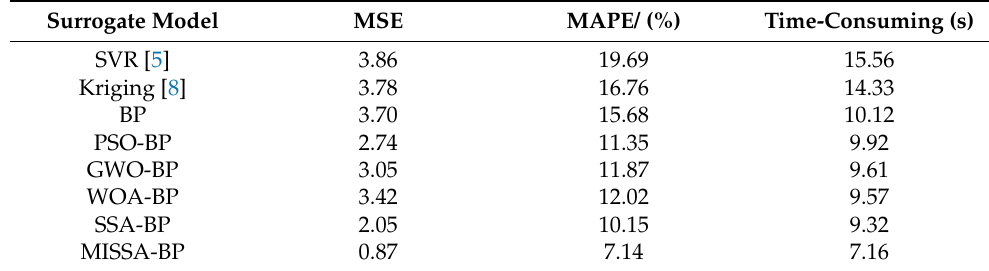
Table 4. Prediction accuracy of each optimized agent